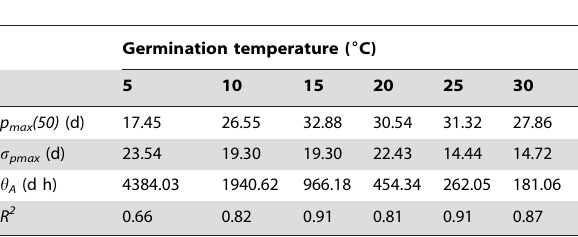
Table 2. Parameters of the maximum lifetime threshold (MLT) model described the germination of aspen seeds across a series of storage periods of time at a given temperature (equation (4)).